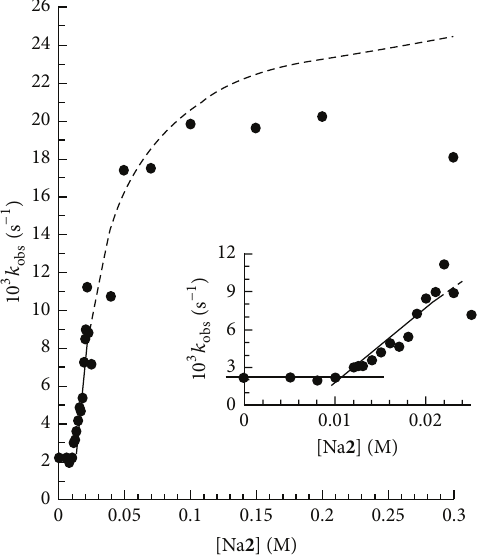
Figure 3: Plot showing the dependence of 𝑘 upon [Na 2 ], for obs piperidinolysis of 3H at 0.2 mM PSa − , 0.1M 4 , 0.03 M NaOH, and 35 ∘ C.Thesolidlineisdrawnthroughthecalculateddatapointsusing and 𝐾 𝑋/𝑆 ), listed in Table 2. The (2) with kinetic parameters ( 𝑘 cat dotted line is drawn through the predicted data points assuming the presence of WM at [ Na 2 ] op 0 < [Na 2 ] ≤ 300